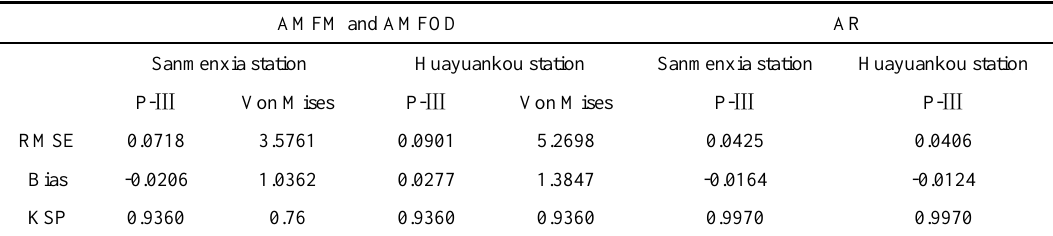
Table3. Parameters testing results of von Mises and P- Ⅲ distribution of Sanmenxia and Huayuankou